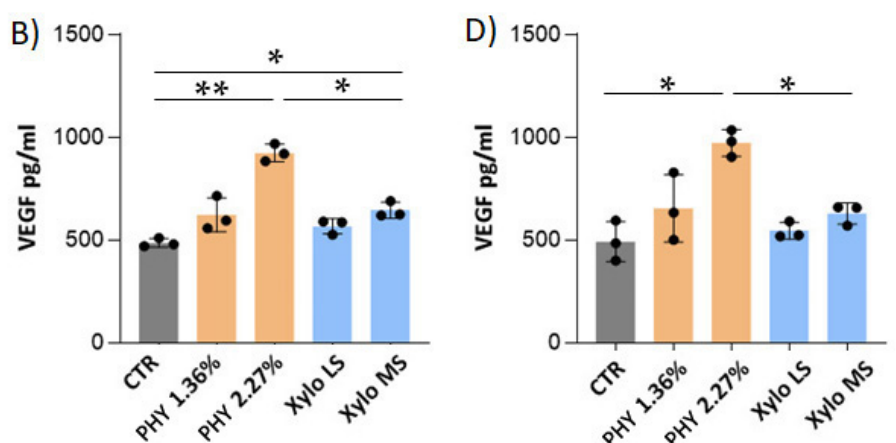
Figure 9. Expression and release of VEGF by endothelial and mesenchymal cells. ( A , C ) VEGF gene expression. The analysis was performed as described in Figure 5. ( A ) CTR vs. PHY 2.27% p < 0.0001, PHY 2.27% vs. Xylo MS p < 0.0001; ( C ) CTR vs. PHY 2.27% p = 0.0056, CTR vs. Xylo MS p = 0.0092, PHY 2.27% vs. Xylo MS p = 0.0078 * p < 0.05, ** p < 0.001. ( n = 6 biological replicates) VEGF soluble protein was quantified in conditioned medium obtained after 24 h of incubation of HMRSV5 mesothelial cells ( B ) and in HUVEC endothelial cells ( D ) pre-treated for 3 h in PD or control solution. Values are given as mean ± SD. ( B ) CTR vs. PHY 2.27% p < 0.0001, CTR vs. Xylo MS p = 0.0158, PHY 2.27% vs. Xylo MS p = 0.0012; ( D ) CTR vs. PHY 2.27% p = 0.0066, PHY 2.27% vs. Xylo MS p = 0.0076. * p < 0.05, ** p < 0.001 ( n = 3 biological replicates).